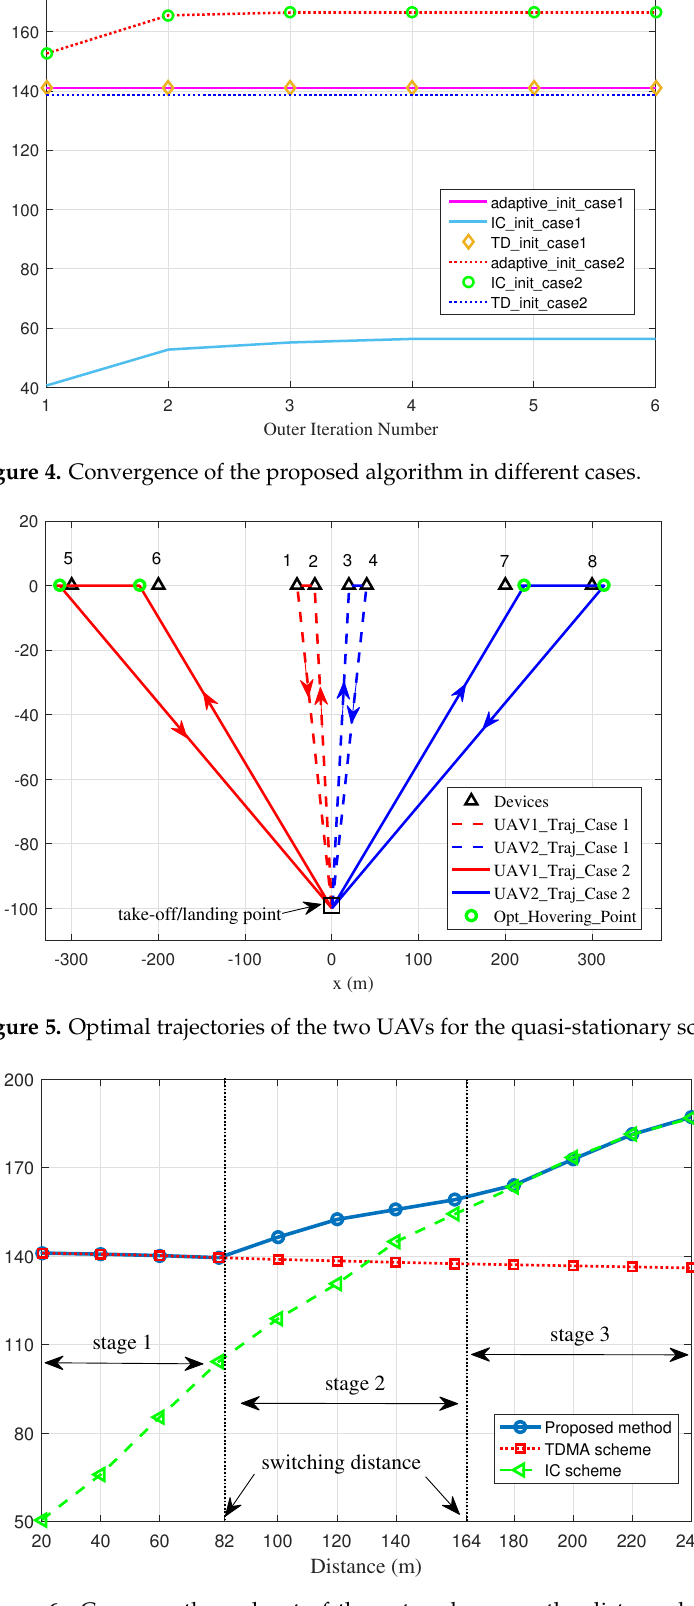
Figure 6. Common throughput of the network versus the distance between devices for differ- ent